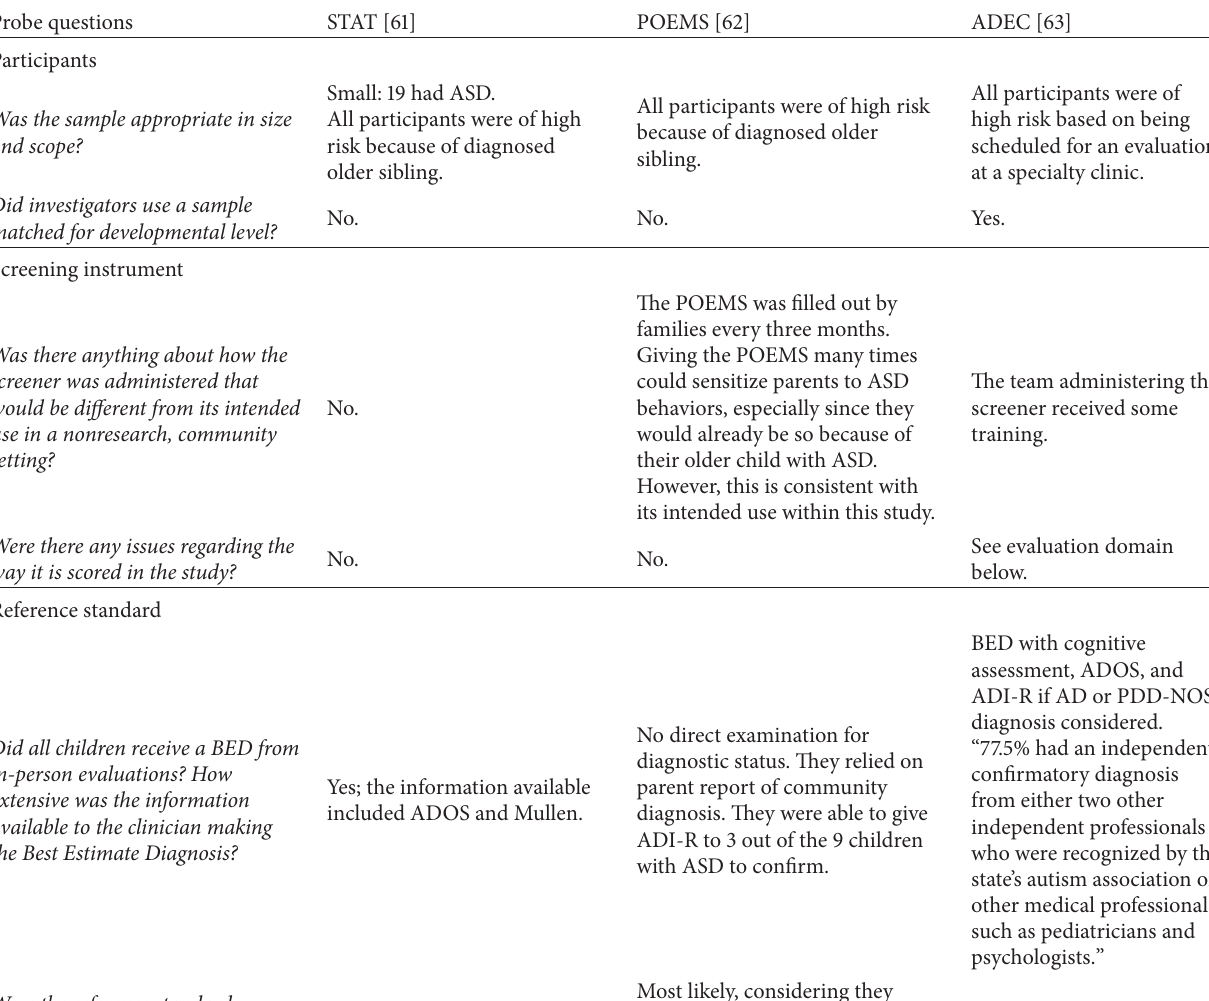
Table 5: Research summaries for the Screening Test for Autism in Two-Year-Olds (STAT), Parent Observation of Early Milestones Scale (POEMS), and Autism Detection in Early Childhood